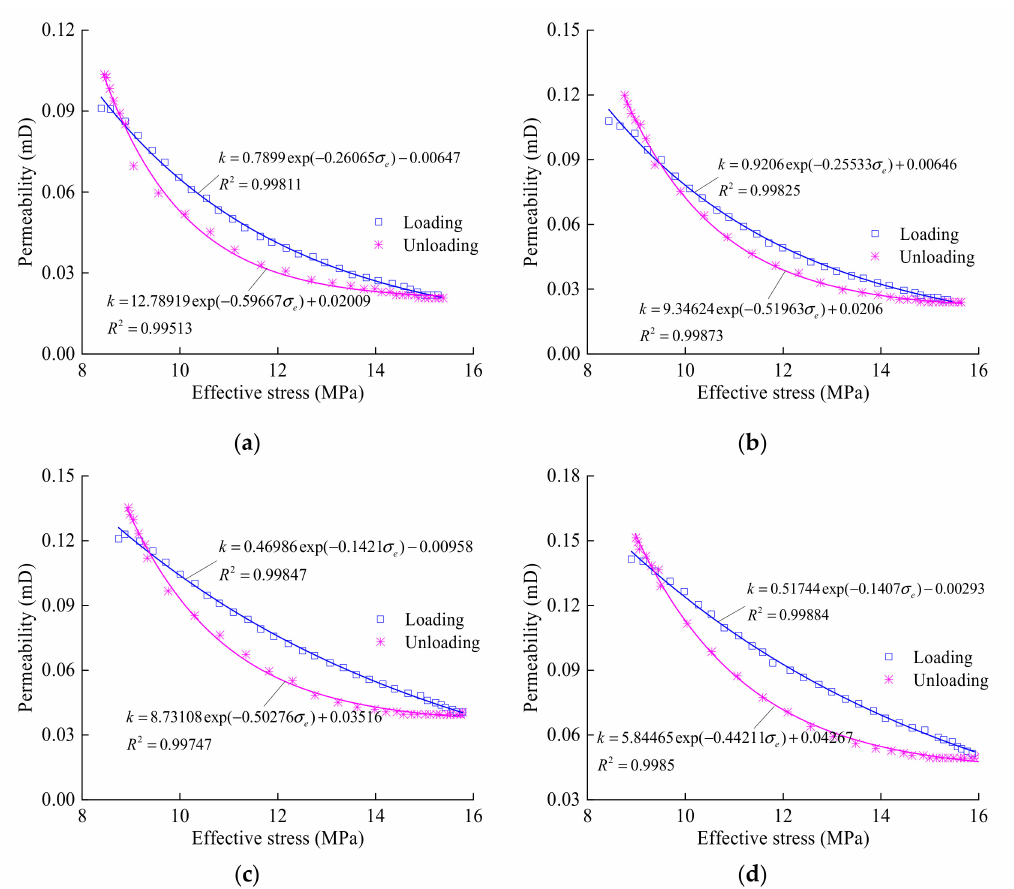
Figure 10. Fitting curves of e ff ective stress-permeability curves during the process of post-peak loading and unloading confining pressure of the water content 0.65%. ( a ) First loading and unloading ( b ) Second loading and unloading ( c ) Third loading and unloading ( d ) Fourth loading and